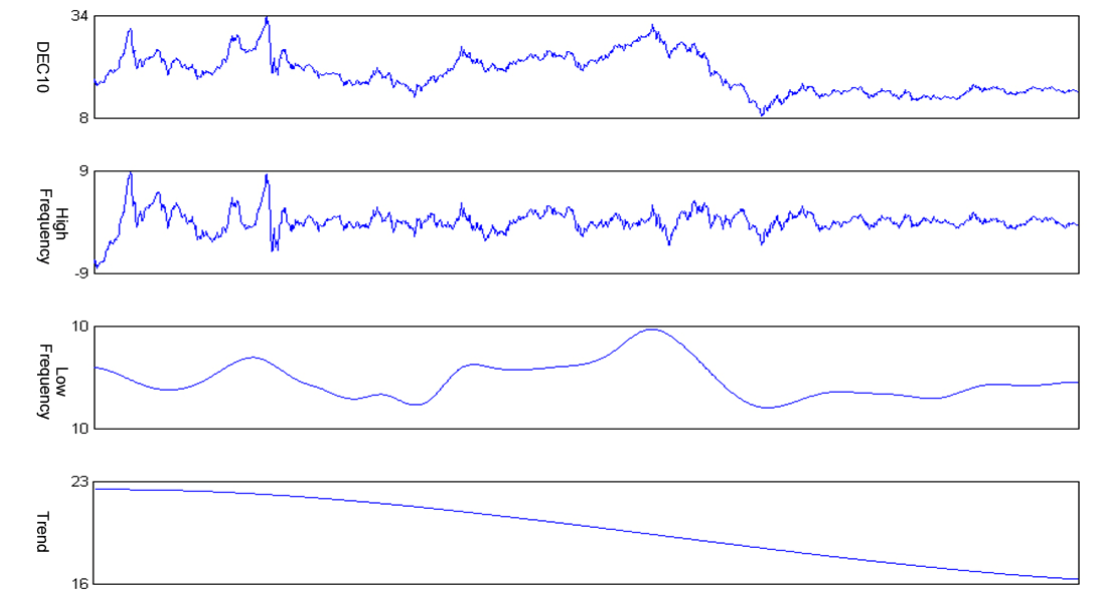
Figure 6. The reconstruction of DEC10 derived from EMD.